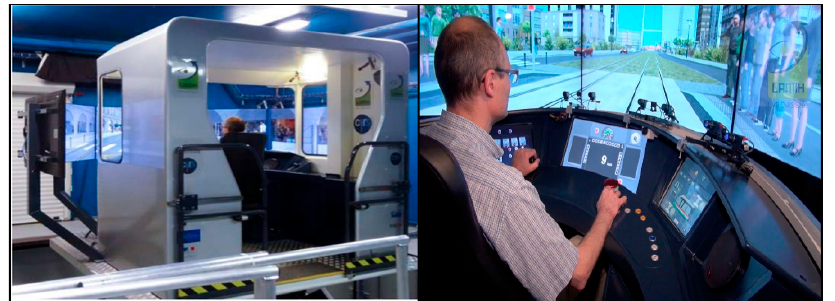
Figure 4 . PSCHITT-RAIL simulator interface . Figure 4. PSCHITT-RAIL simulator